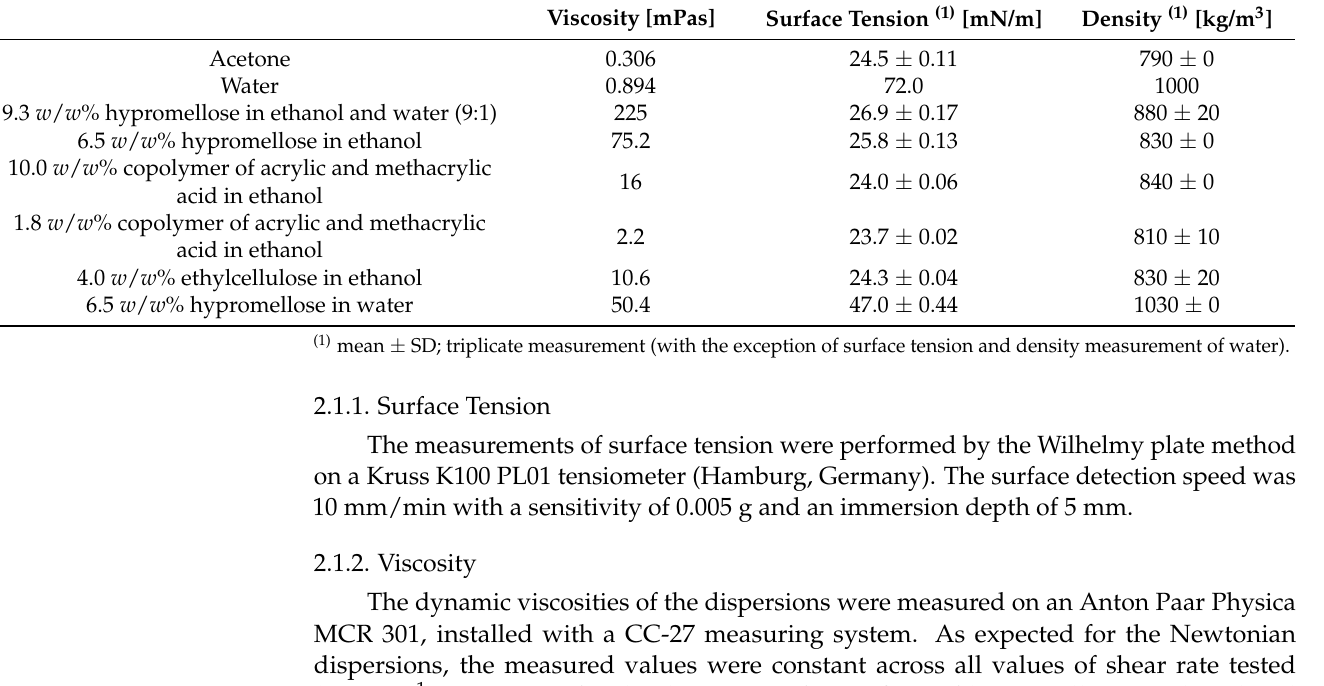
Table 2. Overview of dispersions used and their properties investigated: viscosity, surface tension, and density (6.5 w / w % of hypromellose in water was used only for testing the model constructed and not in the DoE